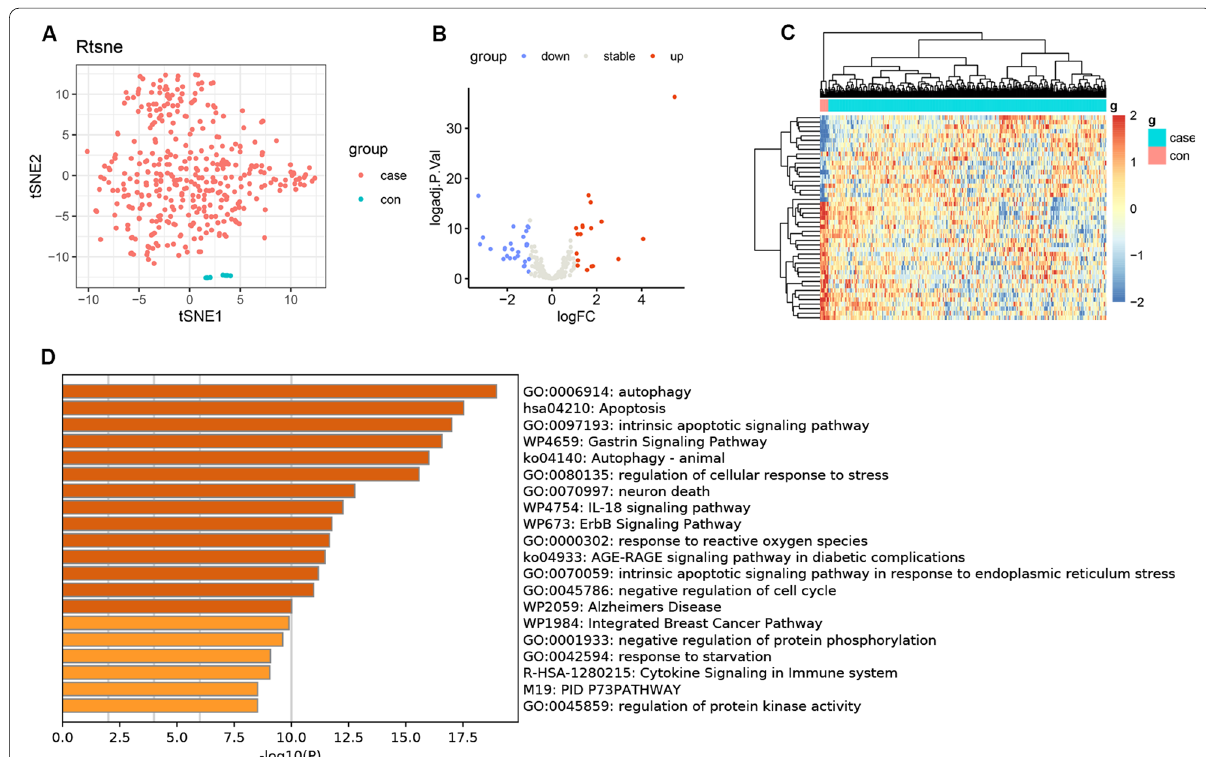
Fig. 1 Identification of differentially expressed ARGs of EC. A Principal component analysis (PCA) between tumors and control samples; the result demonstrated the heterogeneity of the study. Differentially expressed ARGs in the study, 18 upregulated and 27 downregulated ARGs (|log2 FC|> 1, adjusted P -value < 0.05) was shown on B volcano plots and C hot map. Autophagy pathway, apoptosis pathway was major pathway by functional pathway analysis of ARGs was demonstrated on D